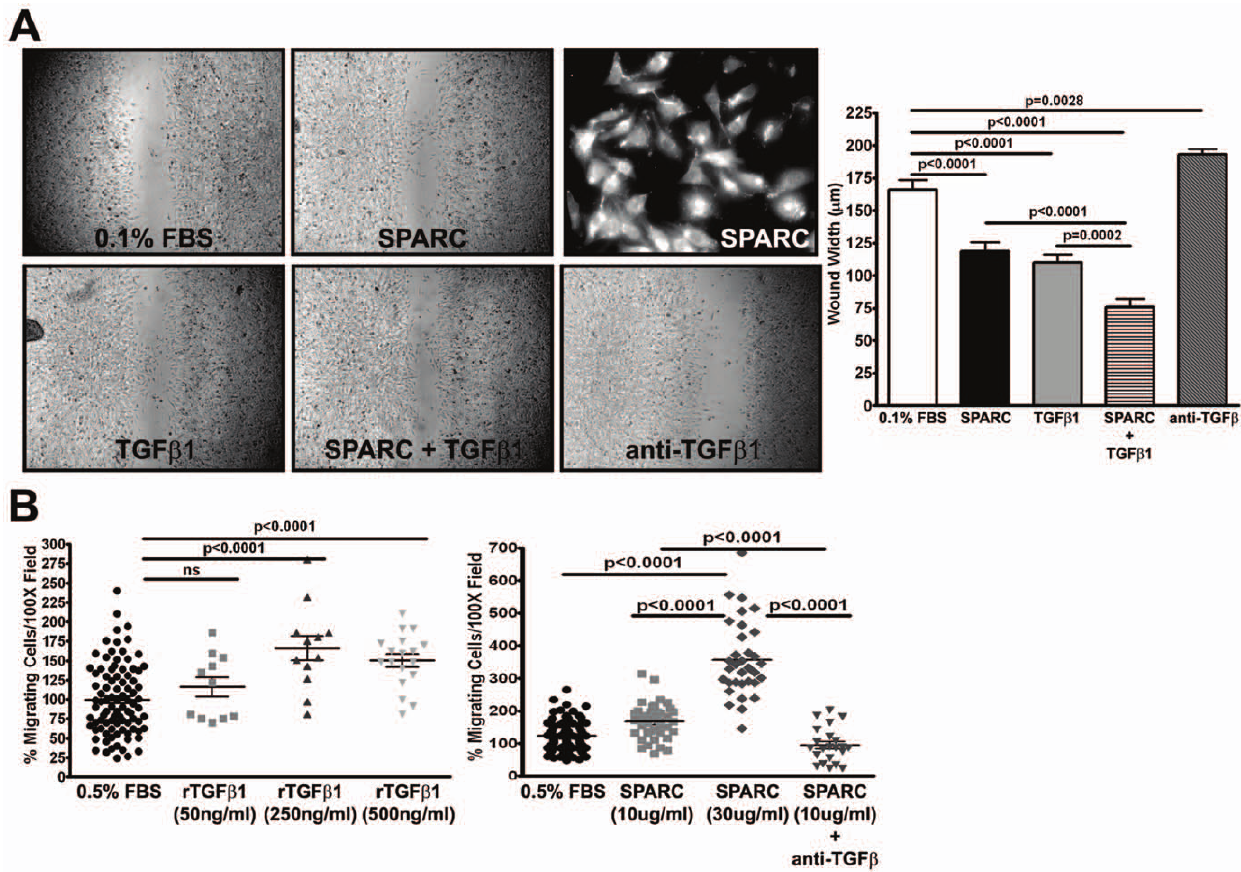
Figure 8. SPARC and TGF b 1 promote Pan02 migration. The ability of SPARC and TGF b 1 to control Pan02 cell migration in vitro was assessed. (A) A wound-healing assay was utilized to determine if SPARC and TGF b 1 could act concomitantly to enhance Pan02 migration. Cells were plated at a density of 1.5 6 10 5 cells per well in 96-well plates and allowed to grow to 100% confluency. A scratch was made and cells allowed to migrate into the wound. Recombinant SPARC (10 m g/ml), recombinant TGF b 1 (250 ng/ml) and anti-TGF b 1,2,3 (10 m g/ml) were prepared in DMEM 0.1% FBS. The wound width ( m m) was measured after 6 hours. Inset of immunocytochemistry with antibody goat anti-mouse SPARC reveals that Pan02 cells do express SPARC. (B) A transwell migration assay was performed as an additional means to assess SPARC and TGF b 1 effect on Pan02 migration, as well as, to determine if SPARC effect on Pan02 migration is TGF b dependent. Cells were serum-starved overnight then seeded at 20,000 cells per 24-well 0.8 m m cell culture insert (BD Falcon). DMEM 0.1% FBS served as the chemoattractant. Recombinant SPARC (10 and 30 m g/ml) was added to the upper chamber, while recombinant TGF b 1 (50, 250 and 500 ng/ml) and anti-TGF b 1,2,3 (5 m g/ml) were added to the bottom chamber. Cells were allowed to migrate 24 hours at 37 u C in 5% CO 2 . Migrated cells were fixed, stained and counted. Cell counts were normalized to DMEM 0.1% FBS and recorded as % migrating cells. ns, not significant. All p-values were calculated with the Student’s t test.